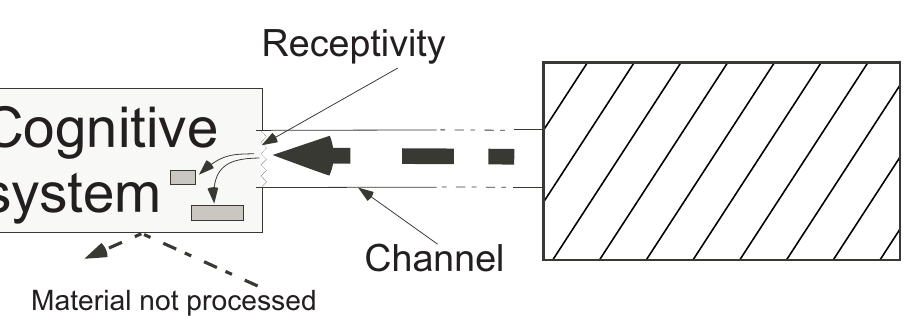
Figure 1. Information and